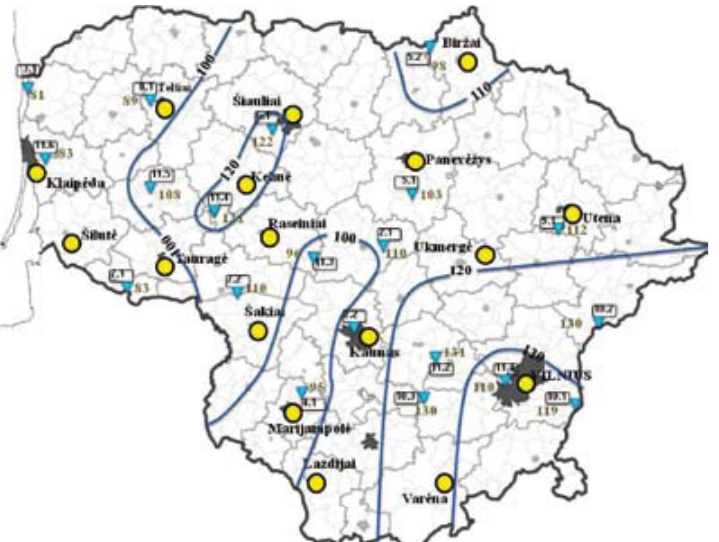
fig. 5. Distribution of the max depth of frozen ground in the territory of Lithuania by RWIS (Juknevičiūtė, Laurinavičius